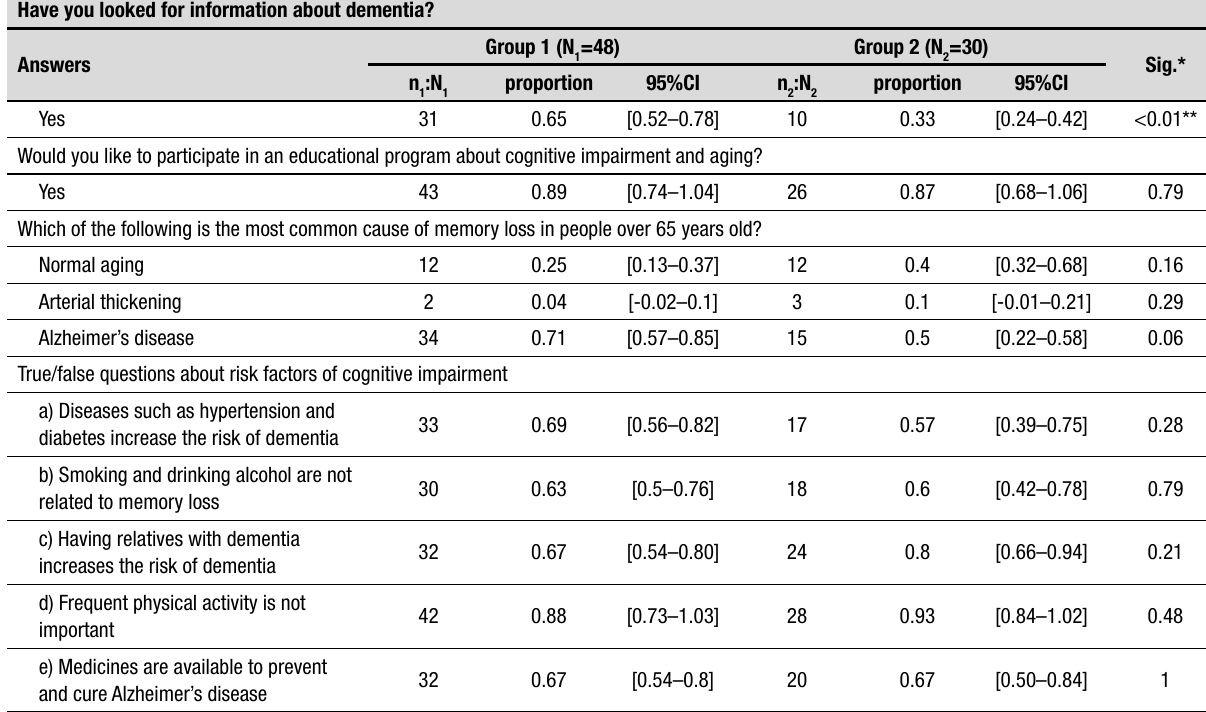
Table 3. Questions about cognitive impairment and dementia: correct answer proportion. Have you looked for information about dementia?